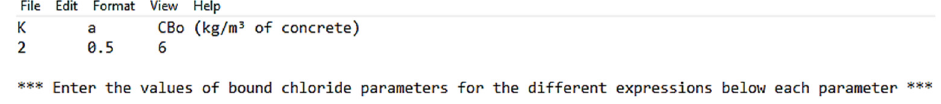
Figure 9. ( a ) Screen to choose the type of isotherm, ( b ) Screen for the introduction of the isotherm´s coefficients.